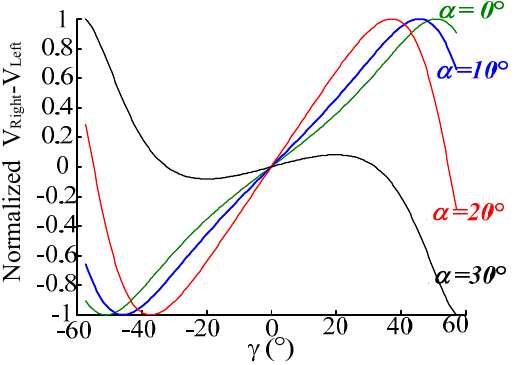
Figure 7. Normalized characteristic curve of V Right − V Left when γ changes. ( α is 0°, 10°, 20°, 30°, respectively, p is 0 μ m, h is 500 μ m).